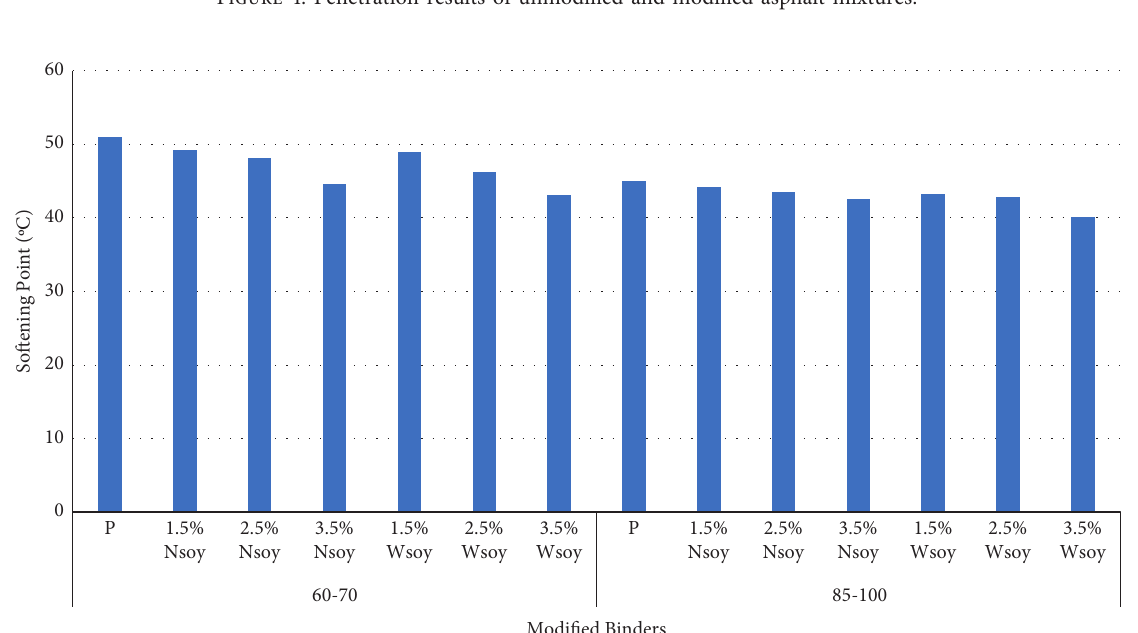
Figure 5: Softening point of unmodified and modified asphalt mixtures.